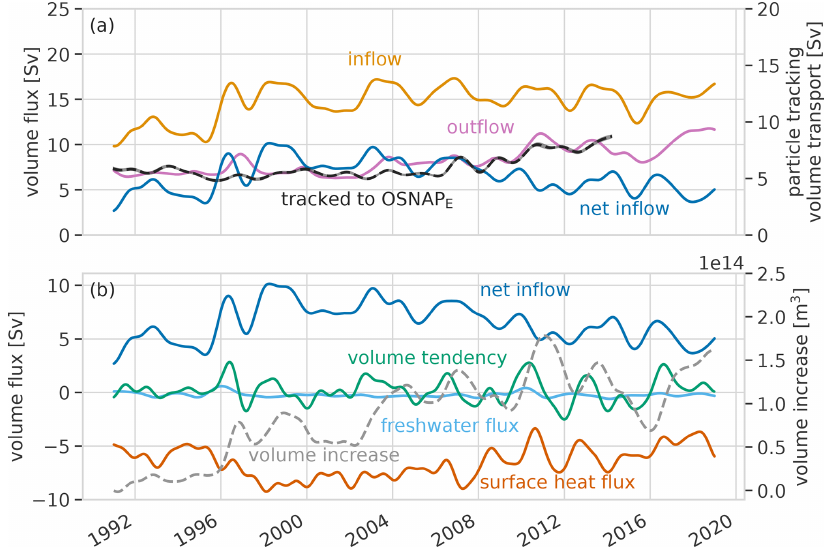
Figure 13. Labrador Sea water mass balance time series for σ 0 < 27 . 65kgm − 3 . The inflow ( a , light orange) shows no clear trend after 1998, whereas the outflow ( a , purple) shows a clear increase. Summing the inflow and outflow shows a reducing net inflow of lighter waters to the Labrador Sea after 1998 (blue line, a, b ). The transport leaving the Labrador Sea and heading to OSNAP E − 37W − 500m from the particle tracking is included in (a) (dashed black line) for comparison. Note the slightly different scale on the right-hand y axis for this line to help comparison, since there is not a 1 : 1 correspondence between water with σ 0 < 27 . 65kgm − 3 leaving the Labrador Sea and water tracked to OSNAP E − 37W − 500m . In (b) , this reduced net inflow of light water must be balanced by water mass volume transformations – heat flux out of the ocean (orange/red line), freshwater flux (light blue) – or show as a changing volume in the volume tendency term (green). Time series are generated from 5d VIKING20X output that was low-pass filtered with a Butterworth filter and an 18-month